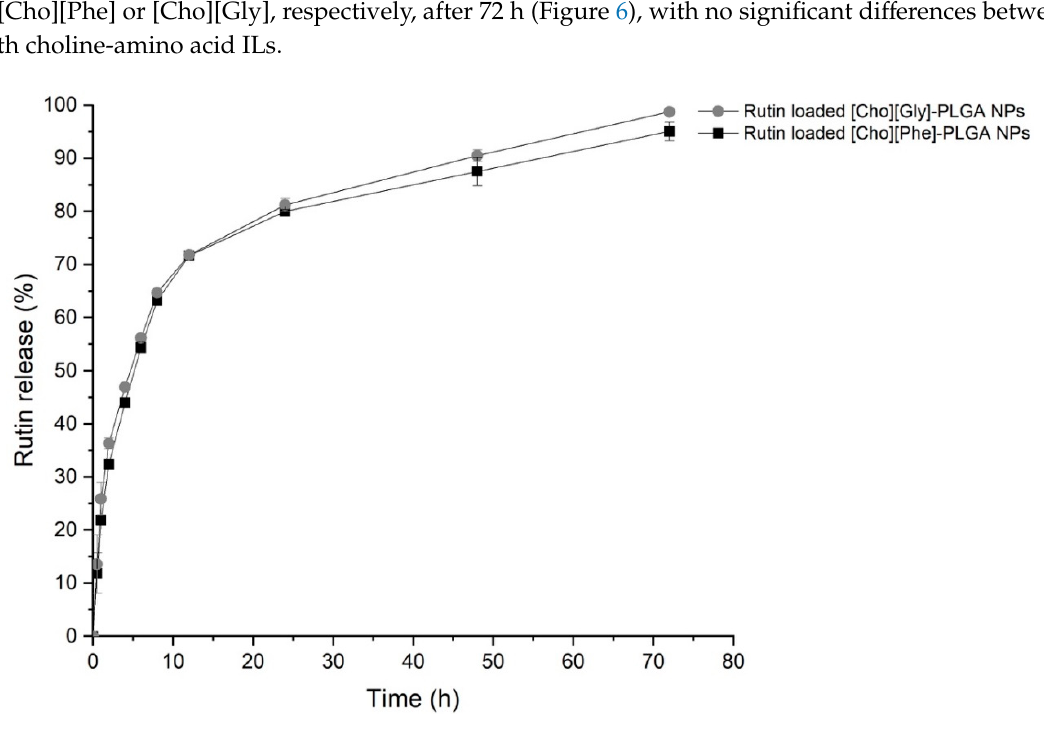
Figure 6. Cumulative release profile of the rutin-loaded IL-PLGA nanoparticle hybrid systems for 72 h in phosphate bu ff er saline at pH 7.4. Data represented as mean ± SD ( n = 3). Statistical analysis performed with one-way ANOVA, Tukey’s test.